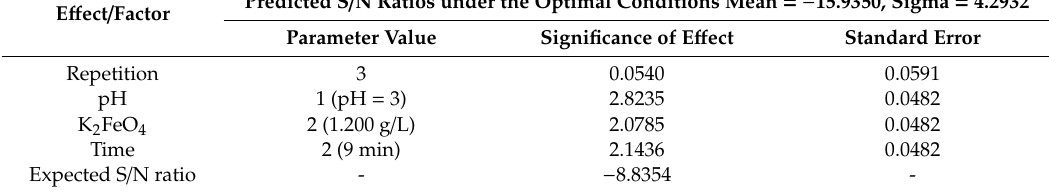
Table 5. S / N ratio under the optimal